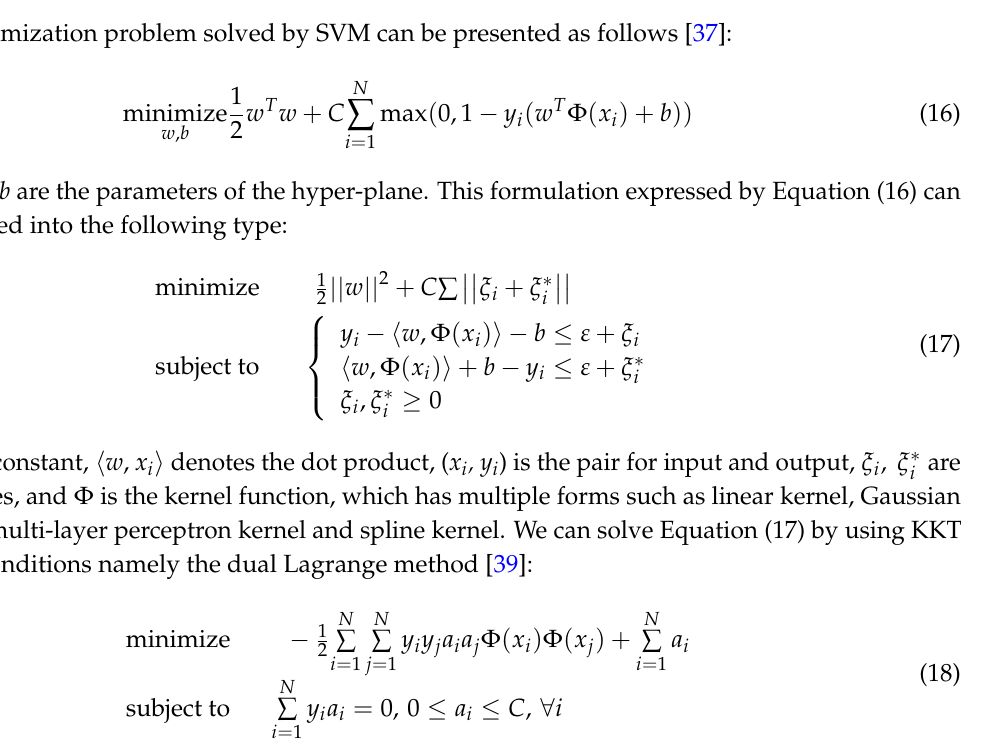
Figure 10. A two-class classification problem by SVM. Data shown by “cross” and “circle” represent binary class +1 and − 1, respectively. w and b are parameters of the hyper-plane.